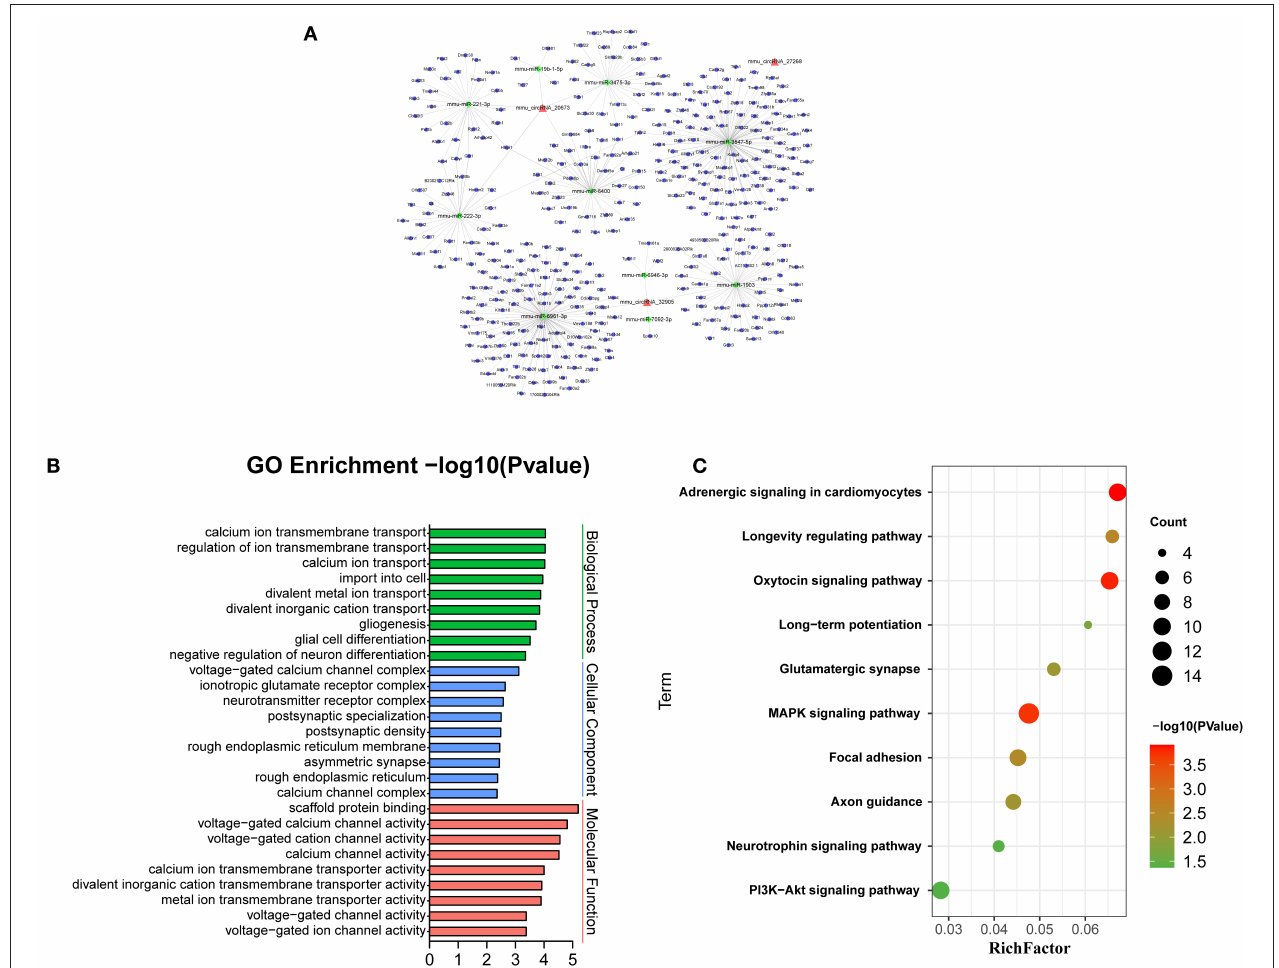
FIGURE 8 | Bioinformatics analysis for target genes of three verified differentially m 6 A-modified circRNAs. (A) The circRNA-miRNA-mRNA network contains 3 circRNAs, 10 miRNAs, and 273 mRNAs. (B) The top ten most enriched functions of the target genes. (C) The top ten most enriched pathways of target